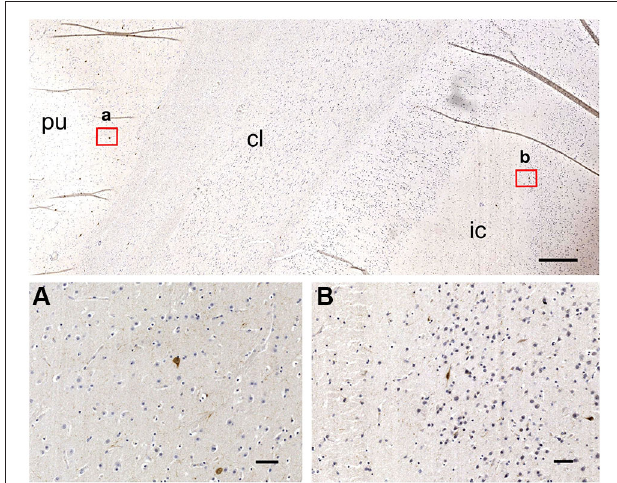
FIGURE 9 | SOM–ir neurons are absent from the chimpanzee claustrum (top), but present in putamen (A) and insular cortex (B) . pu; putamen; cl: claustrum; ic: insular cortex. Scale bars; image at the top = 500 µ m; a, b = 50 µ m.